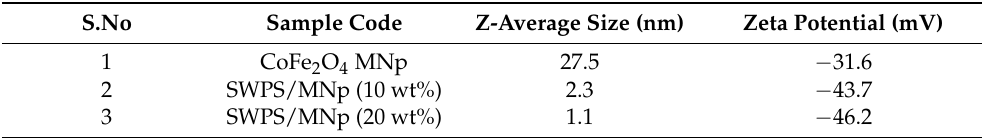
Table 1. Size distribution and zeta potential from DLS measurements of CoFe 2 O 4 MNpand SWPS/MNp (10 and 20 wt%).